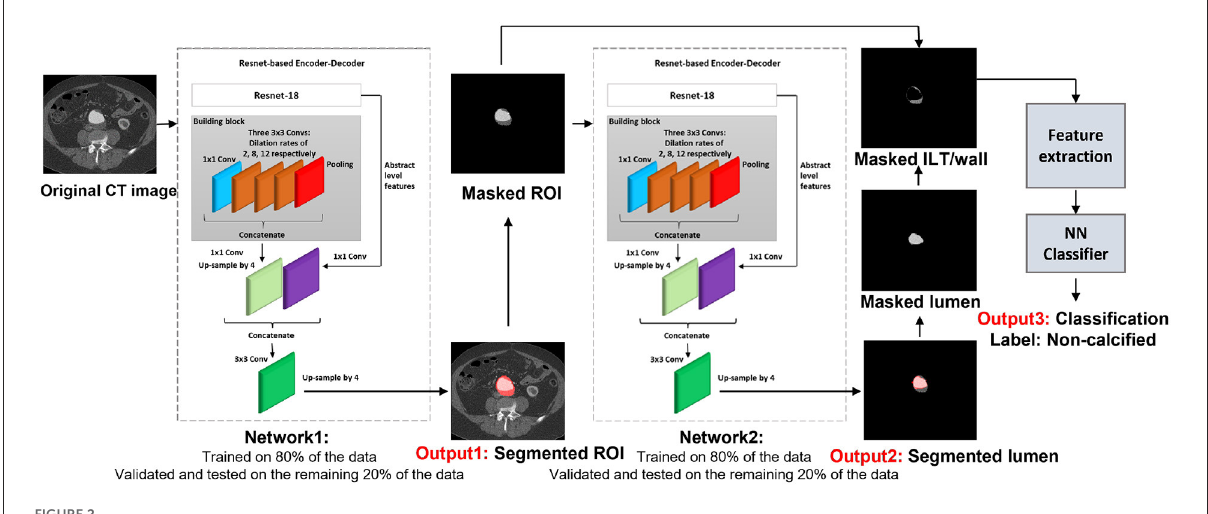
FIGURE2 Visual representation of the network architecture and output for AAA tissue segmentation.